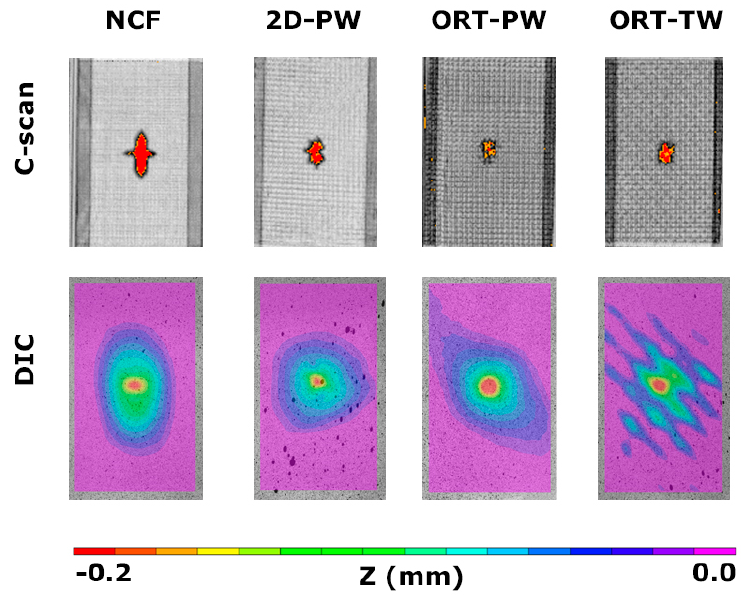
Figure 6. C-scanning and digital image correlation (DIC) results for the impacted